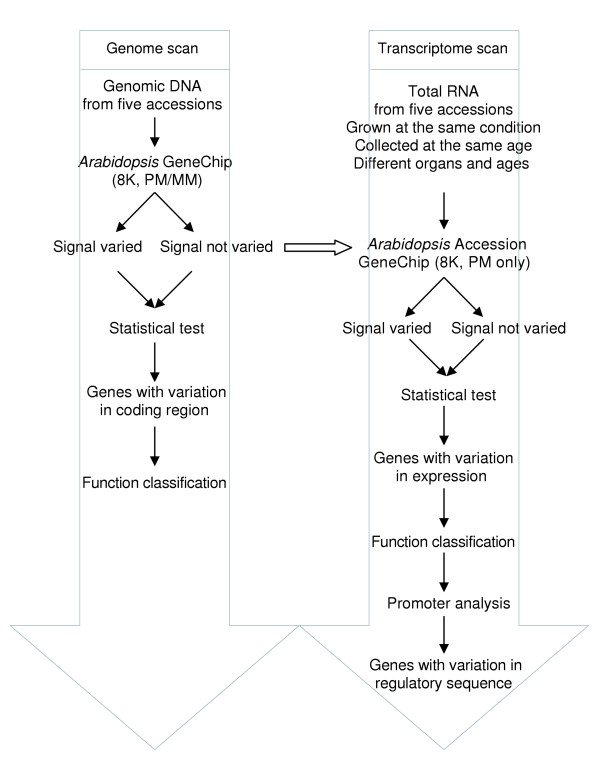
Schematic diagram of the data analysis process. A genome scan (left panel) was used to identify probe sets corresponding to the genes that were highly polymorphic or less polymorphic in gene coding regions among the five accessions. Genes with polymorphic sequences were functionally categorized. Probe sets corresponding to the less polymorphic genes were used for a transcriptome scan of various accessions (right panel). Genes transcribed at different levels in different accessions were identified and analyzed.